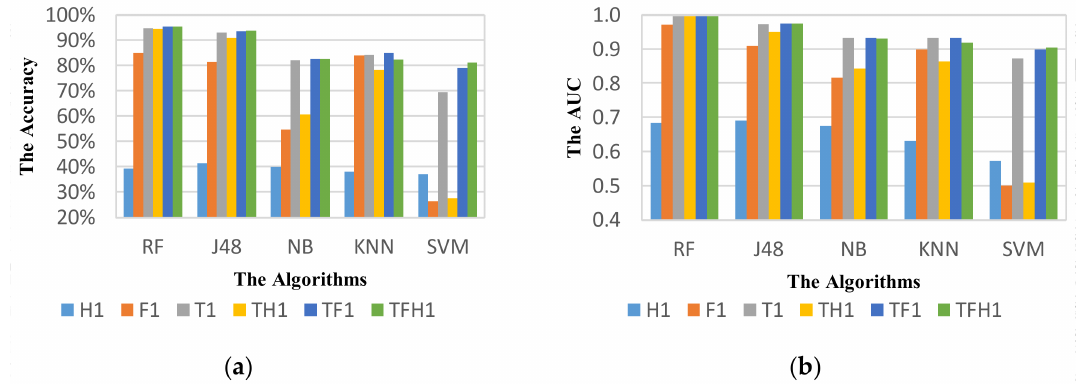
Figure 6. The performance of VDM on different classifiers, and different feature sets with the window size of 5 s at 50% overlapping based on the metric: ( a ) Accuracy; ( b )